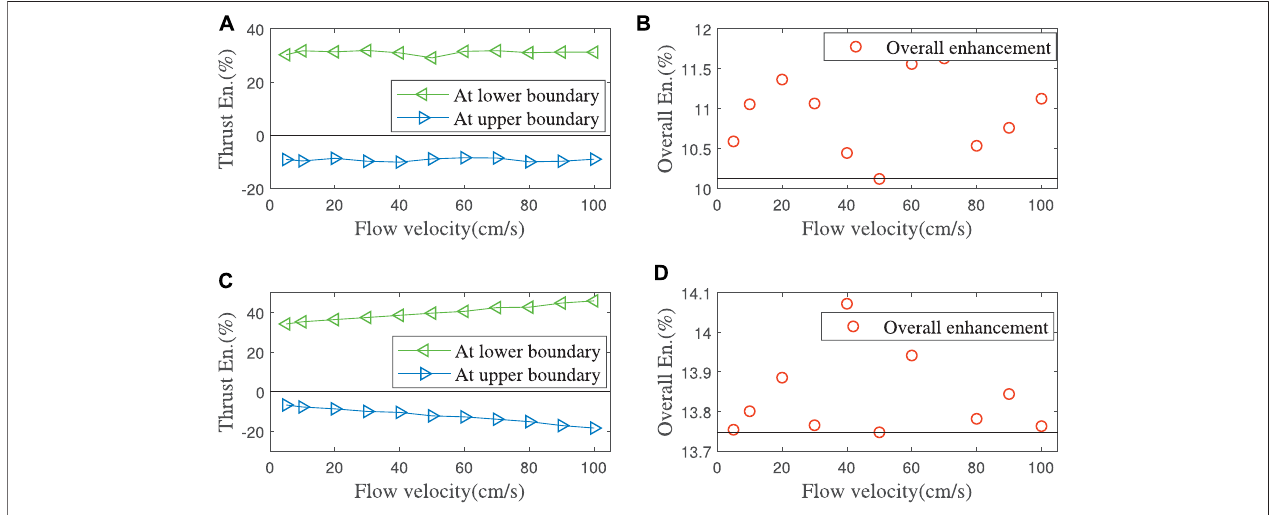
FIGURE9|(A,B) Simulation:Thrustenhancement/losspercentageoftheasymmetricfoilatlower/upperlimitangle.Overallthrustenhancementeffectiscalculated by Eq. 9 . (C,D) Experiments: Thrust enhancement/loss percentage of our asymmetric foil at upper/lower limit angles and its overall thrust enhancement effect.